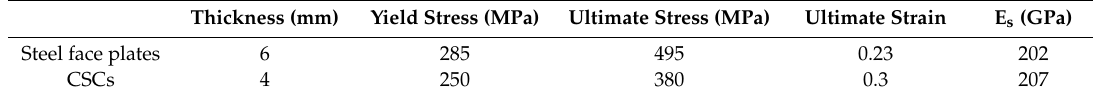
Table 5. Mechanical properties of steel faceplates and CSCs.